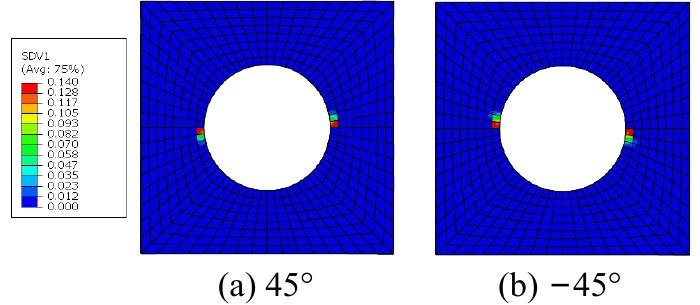
Figure 27. The initiations regions for interface debonding based on FFNN method.